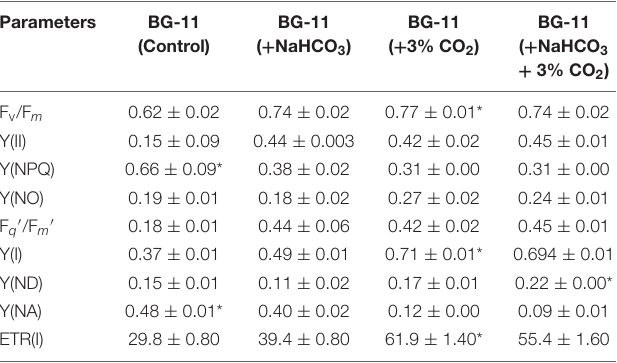
Abbreviations for the labels included in the table are as follows: F v /F m , maximum photochemical efficiency of PSII; F q (cid:48) /F m (cid:48) , PSII operating efficiency; Y(II), quantum yield of photochemical quenching; Y(NPQ), quantum yield of non-photochemical quenching; Y(NO), energy dissipated as heat or fluorescence; Y(I), quantum yield